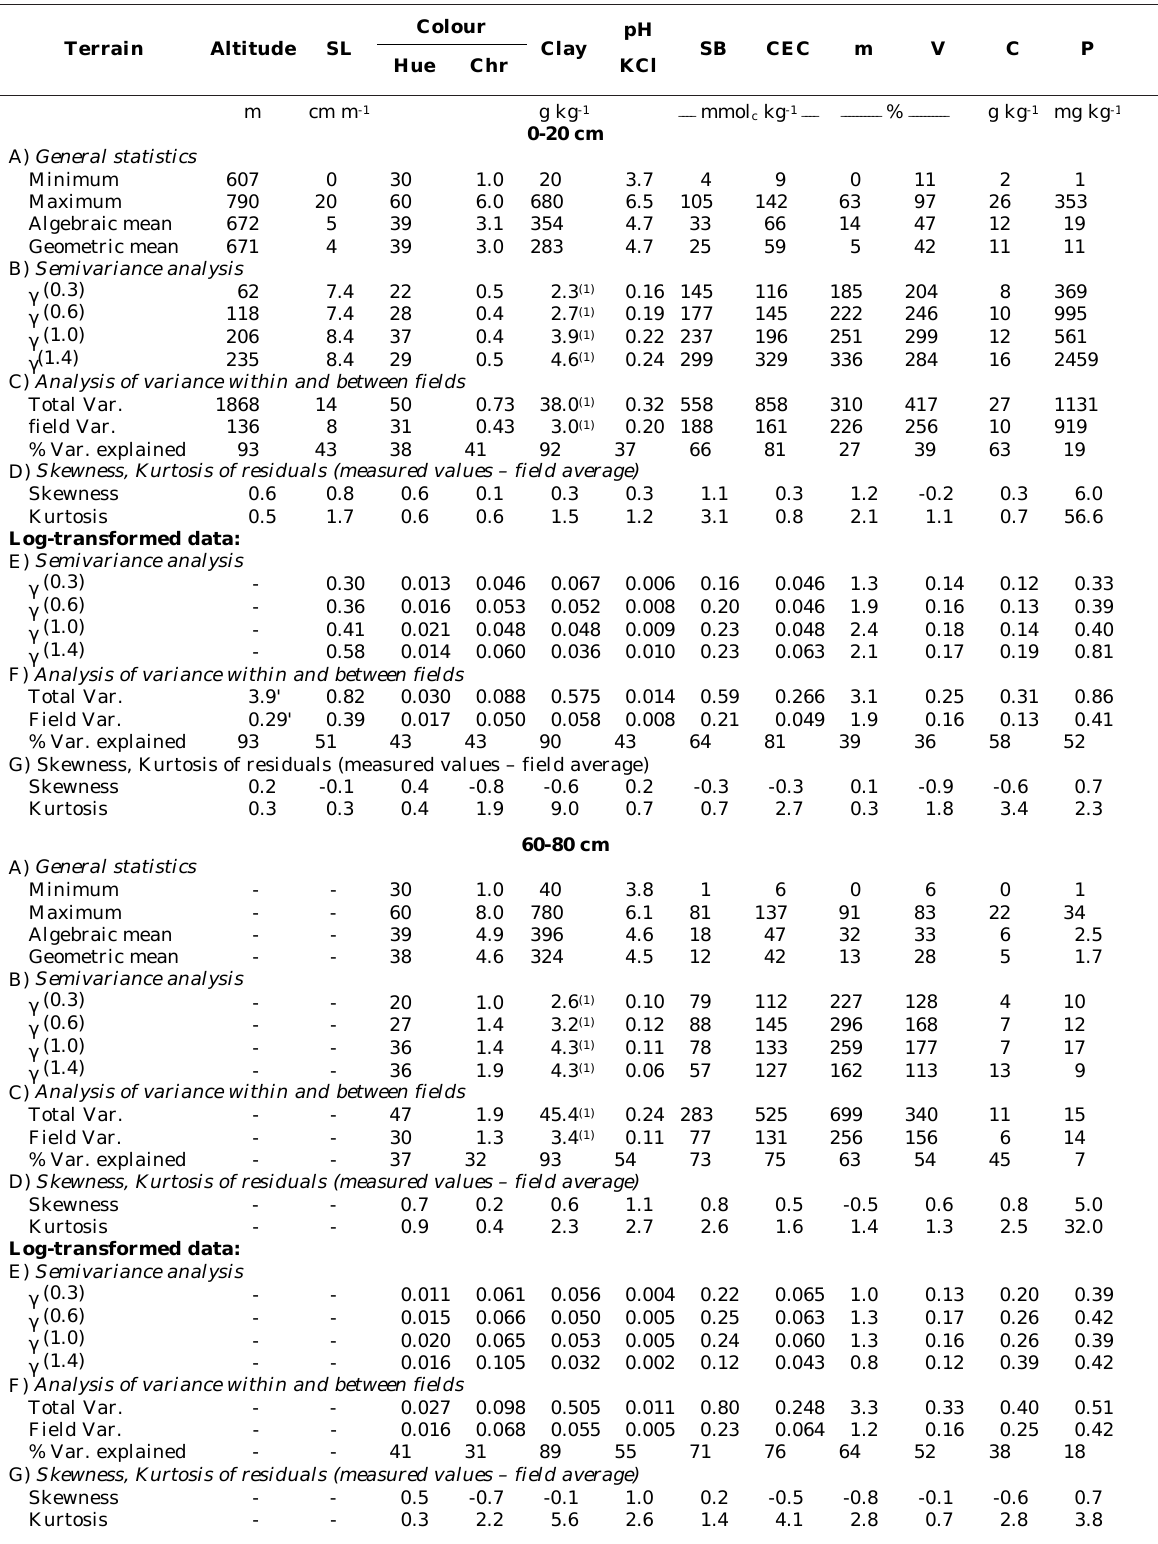
Table 1. Summary of statistical analysis of soil characteristics of the fields in the Araras region (15 fields, 166 sites)